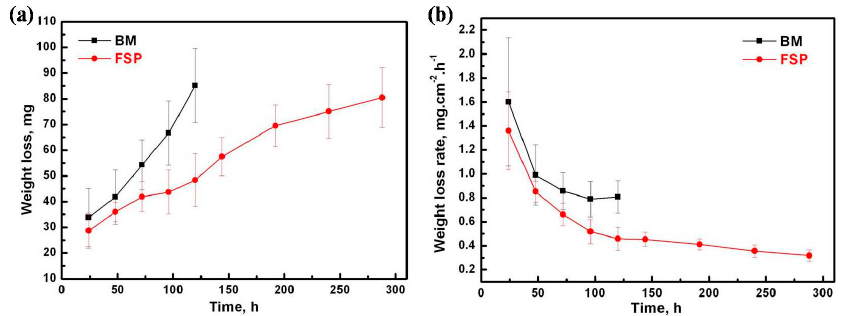
Figure 5. ( a ) The weight loss and ( b ) corrosion rate curves of specimens during immersion test.